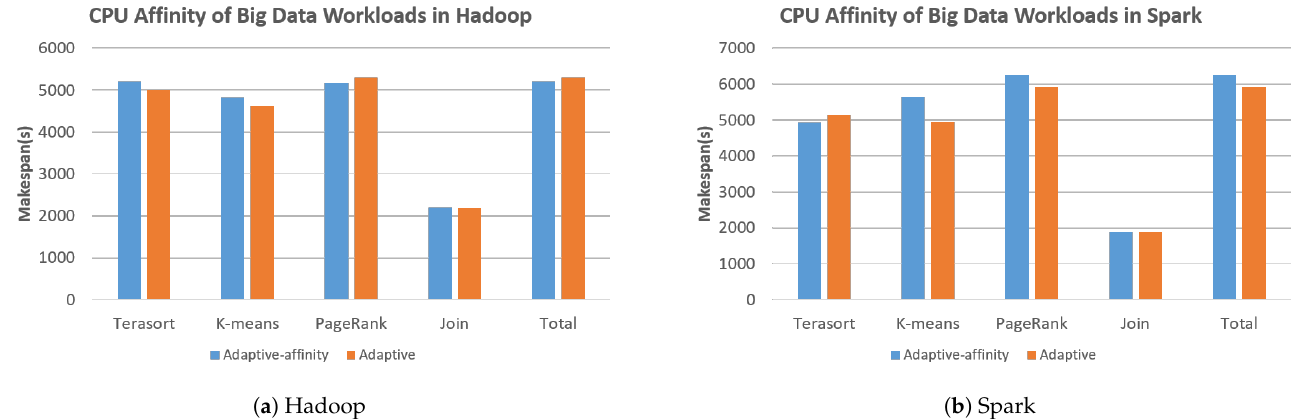
Figure 6. Effects of CPU Affinity, which limits the use of only specific CPUs by setting a fixed set of CPU thread numbers for Big Data